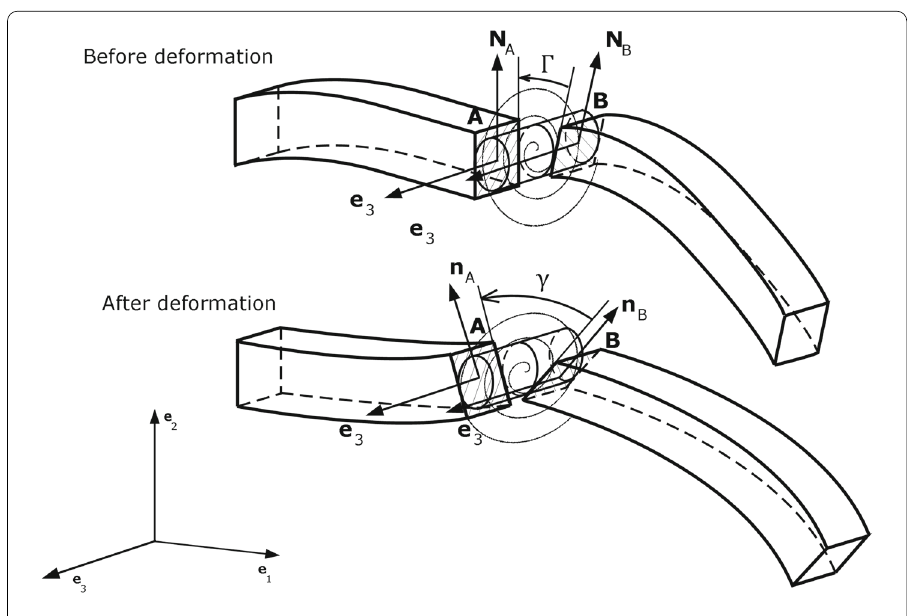
Fig. 3 Revolute pair with torsional